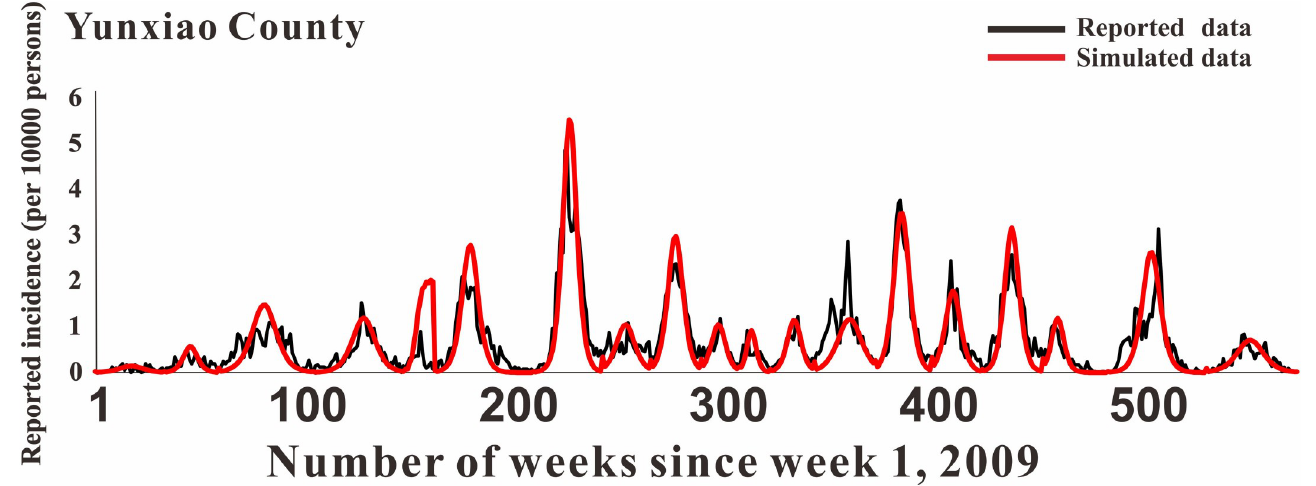
Fig 10. Epidemics of HFMD and LDE model fittings within Yunxiao